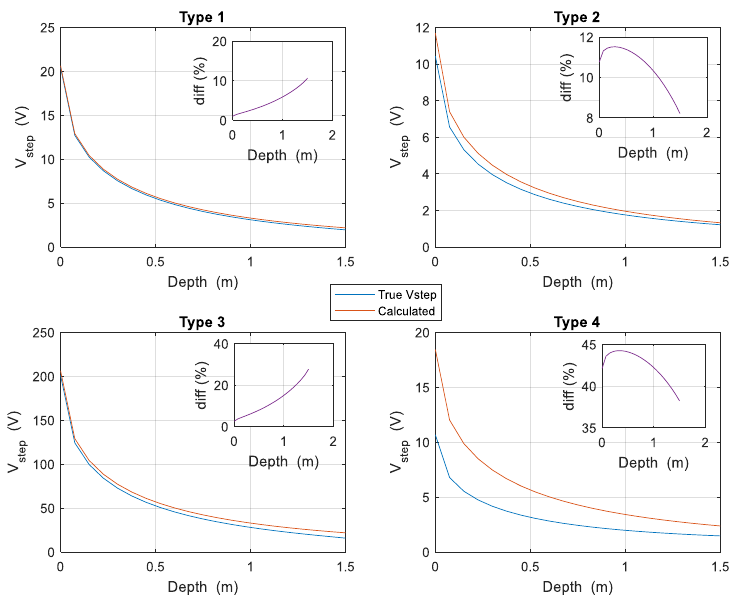
Figure 4. Step potentials created by the complex electrode of Figure 1 for all types of two-layered soils considered, as a function of the burial depth. The upper bound is shown in continuous red line while the real value is in continuous blue line.